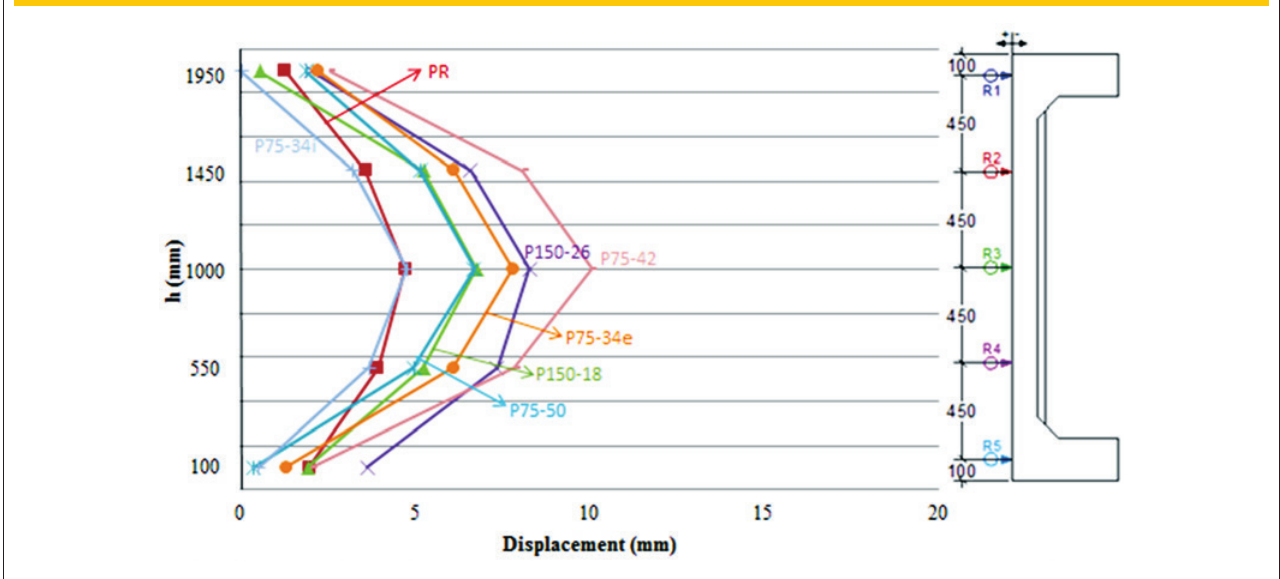
Figure 10 – Horizontal displacement on face T along column height at 300 kN load